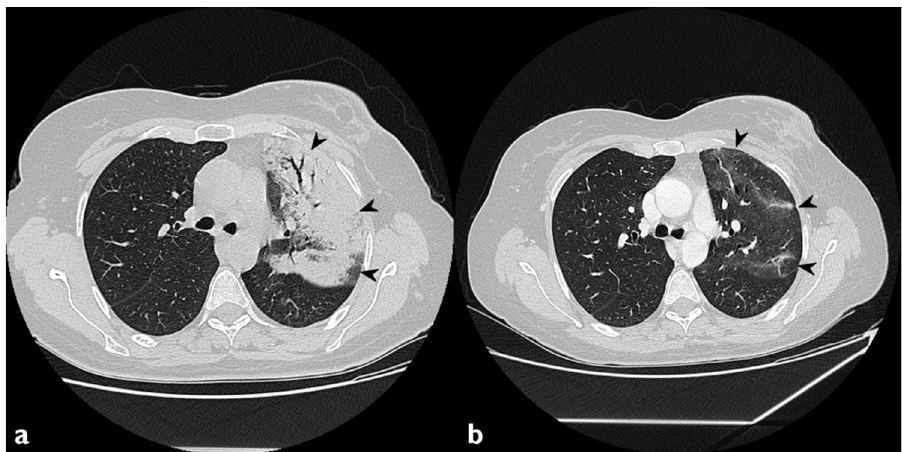
Figure 10. On the left ( a ): baseline HRCT; left parenchymal consolidations with air bronchogram sign